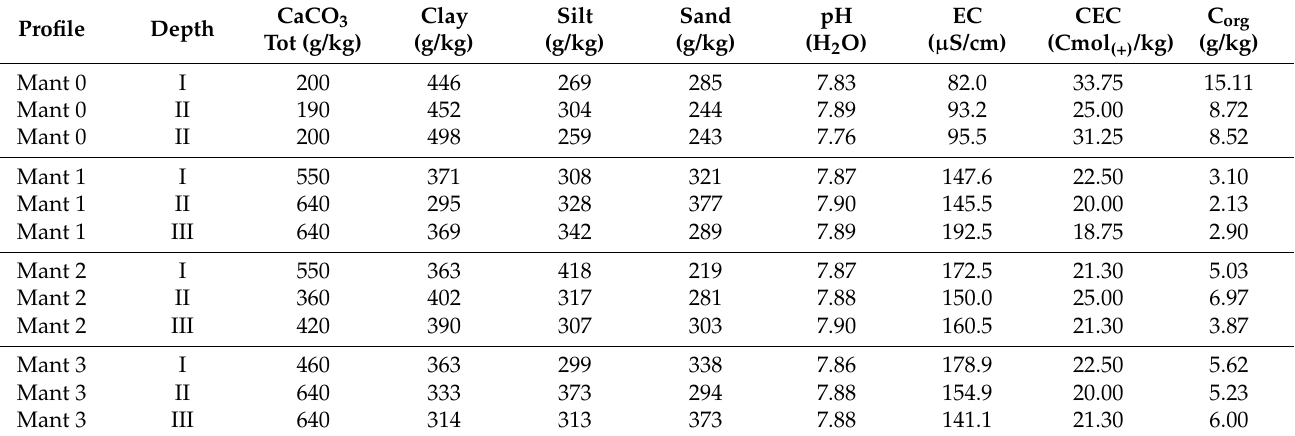
Table 1. Main physicochemical features of investigated anthropic soils profiles in Giordano